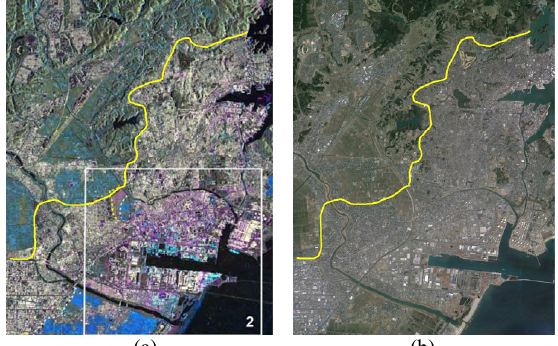
(b) Figure 5. (a) Cutout from the thematic map within a composite area. The meanings of the symbolic colors are described in the caption of Figure 3. The frame of this area can be seen within the pink square in Figure 1. The yellow line specifies the boundary between the flood-free (top-left part) and flood- influenced (down-right part) areas. (b) The counterpart of (a) with the Google Earth image overlaid for overview of ground situation. Figure 6(a) indicates the stretched difference image where the nominal changes spread across the whole scene inclusive of flood-free and flood-influenced areas. The changes are highlighted by bright and dark grayscale values here. Figure 6(b) shows the result of applying Curvelet filtering to the stretched difference image. The distinction between Figures 6(a) and 6(b) is visually clear. The false alarms in Figure 6(b) are filtered out quite effectively either across the flood-free area or in the flood- influenced area. Only the linear-feature changes are preserved. In short, the aim of Curvelet filtering has been achieved in this step. The same thresholding is used to extract the linear-feature changes in both the difference images with and without Curvelet filtering. Both resultant extracted changes, which are marked by whites, are displayed in Figure 7. In the case without Curvelet filtering (Figure 7(a)), many false alarms exist throughout the entire scene. Since no filtering of any kind is applied, all types of change and false alarms have been extracted at